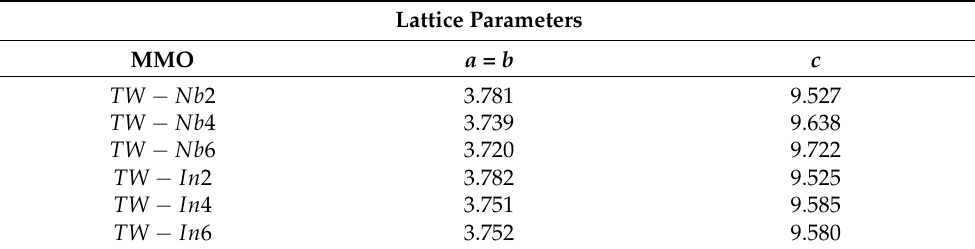
Table 1. Lattice parameters of TiO 2 in TW − Nb and TW − In mixed metal oxides (MMO). Lattice